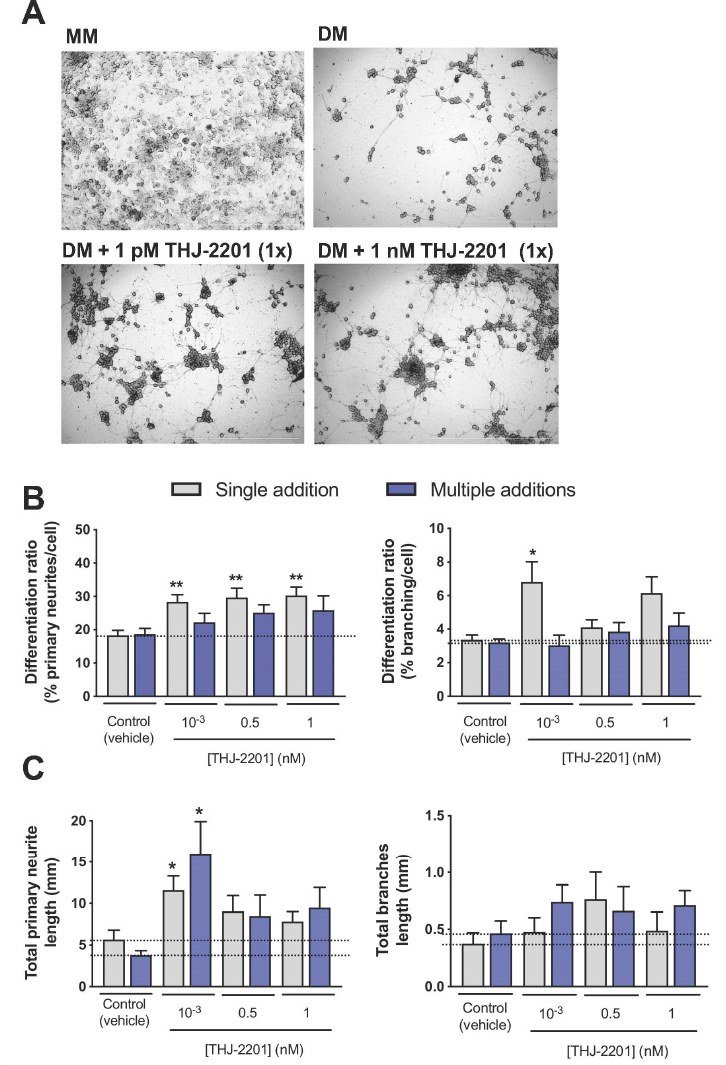
Figure 3. E ff ects of THJ-2201 on neuronal di ff erentiation. Neuronal di ff erentiation was induced by replacing maintenance medium (MM) by di ff erentiation medium (DM) in the presence of the SC or the vehicle (0.1% DMSO). THJ-2201 was added to NG108-15 cells either once (single addition at day 0, in grey) or every 24 h up to 72 h (total of 3 additions, in purple). ( A ) Representative images of NG108-15 cells 72 h following induction of di ff erentiation, and treated once with 0.1% DMSO (vehicle control) or THJ-2201, at 1 pM and 1 nM. Cells cultured in MM (in the absence of di ff erentiation factors) continued to proliferate, preventing the analysis of neurite outgrowth. Scale bars correspond to 1000 µ M; ( B ) di ff erentiation ratios for primary neurites (left panel) and branches (right panel), calculated as the number of neurites longer than 20 µ m divided by the total number of cells per well. ( C ) Total neurite length of primary neurites (left panel) and branches (right panel). Bars show the mean ± SEM, from at least five independent experiments, performed in duplicate. * p < 0.05, ** p < 0.01, compared to vehicle control (one-way ANOVA, followed by Dunnett’s